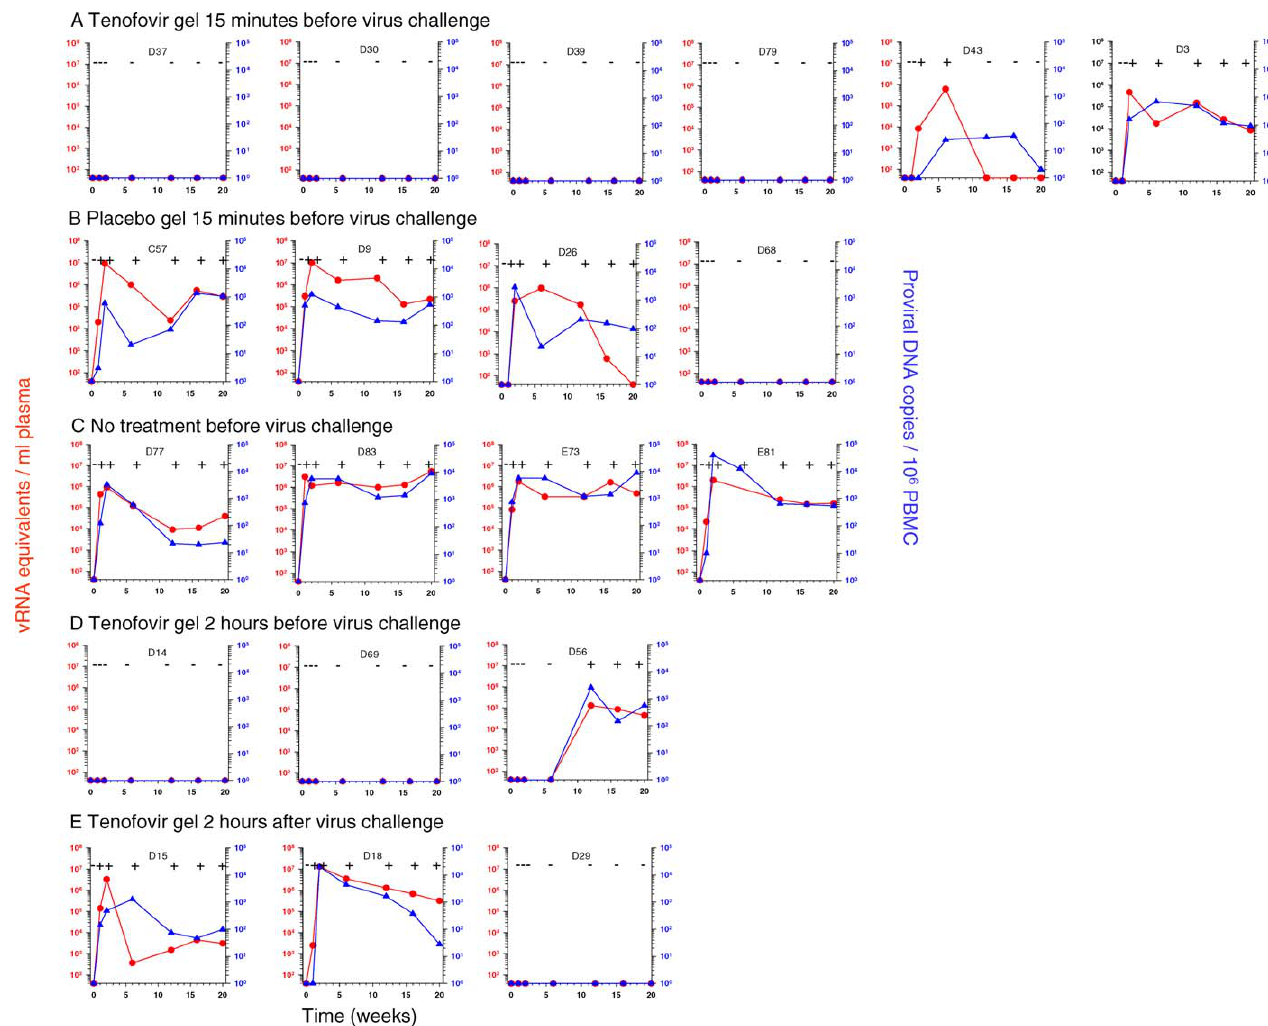
Figure 2. Rectal Administration of Tenofovir Gel Protected a High Proportion of Macaques against Subsequent Acquisition of SIV by Rectal Transmission The results of VI from PBMC are shown as þ or (cid:2) for each animal. The temporal profiles of plasma vRNA concentration (red dot) and frequency of PMBC- associated proviral DNA (blue triangle) are shown for each animal in the study.